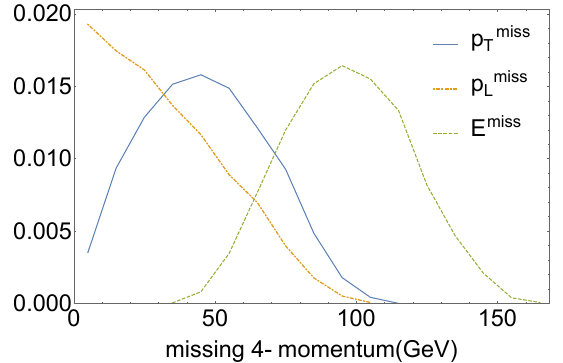
, missing longitudinal T